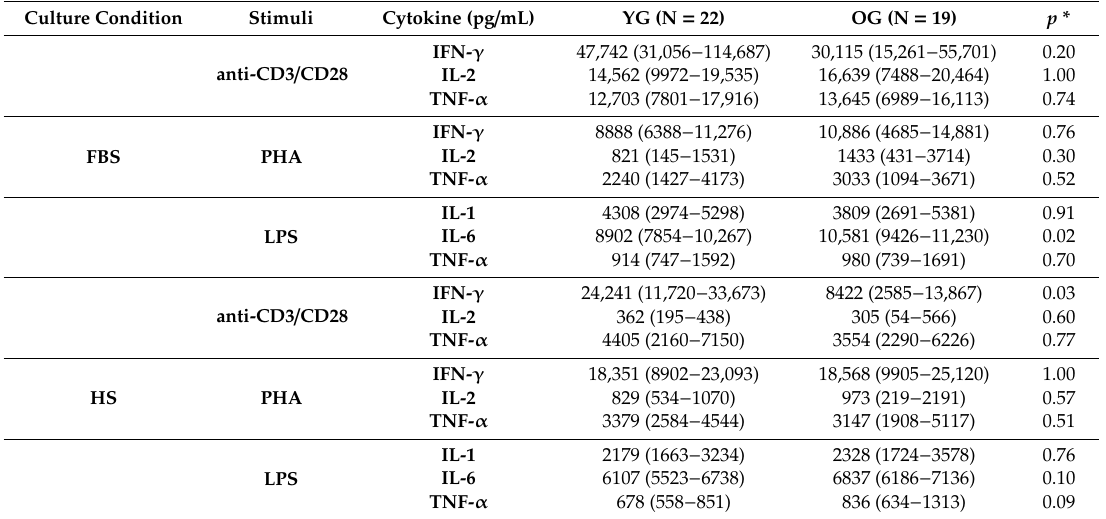
Table 3. Ex vivo cytokine production by stimulated PBMC from young and older women with obesity. Culture